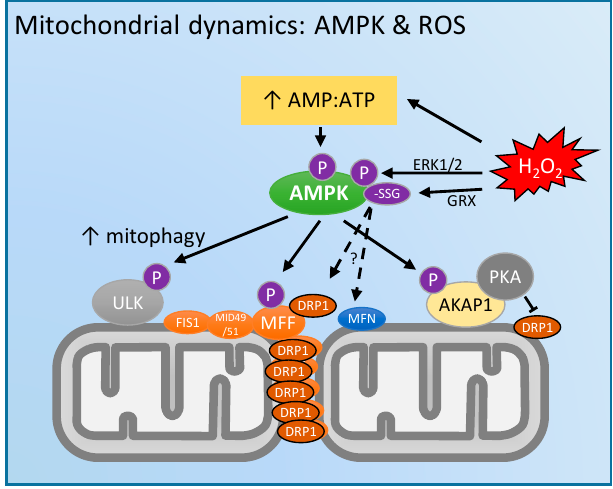
Figure 3. Known and putative roles of 5'-adenosine monophosphate (AMP)-activated protein kinase (AMPK) and ROS mediated regulation of mitochondrial dynamics processes. Under energetically stressful conditions, rising AMP levels relative to ATP are sensed by AMPK which leads to the phosphorylation of downstream targets including: MFF to promote DRP1 binding, unc-51 like autophagy activating kinase (ULK) to induce mitophagy, and A-kinase anchoring protein mitochondrial (AKAP1) to bind cyclic-AMP-dependent protein kinase (PKA), leading to the inhibitory phosphorylation of DRP1 Ser637. In addition, ROS may modulate AMPK via AMP:ATP levels, extracellular signal-regulated kinase (ERK1/2) mediated phosphorylation, and additionally via glutaredoxin (GRX) mediated S -glutathionylation. However, the redox regulation of AMPK has not been experimentally shown to directly modulate fission/fusion dynamics.